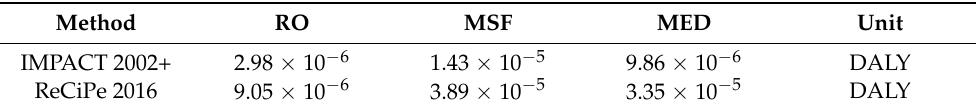
Table 7. Results for the human health category for the three technologies based on the ReCiPe 2016 and IMPACT 2002+